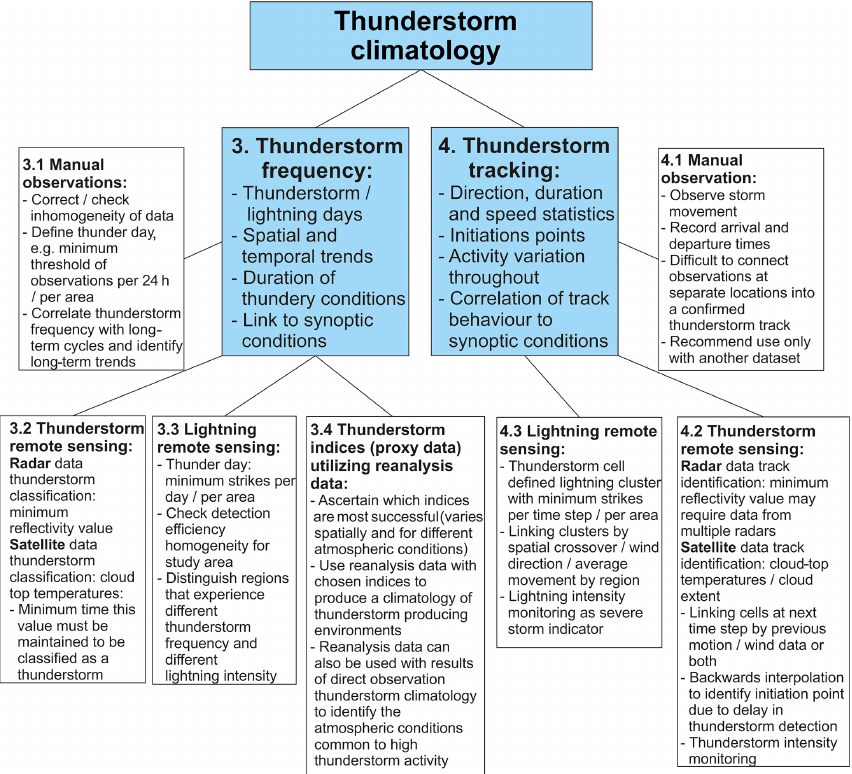
Figure 3. Diagrammatic summary of the potential research findings and data utilisation for a thunderstorm climatology created using either thunderstorm frequency or thunderstorm tracking